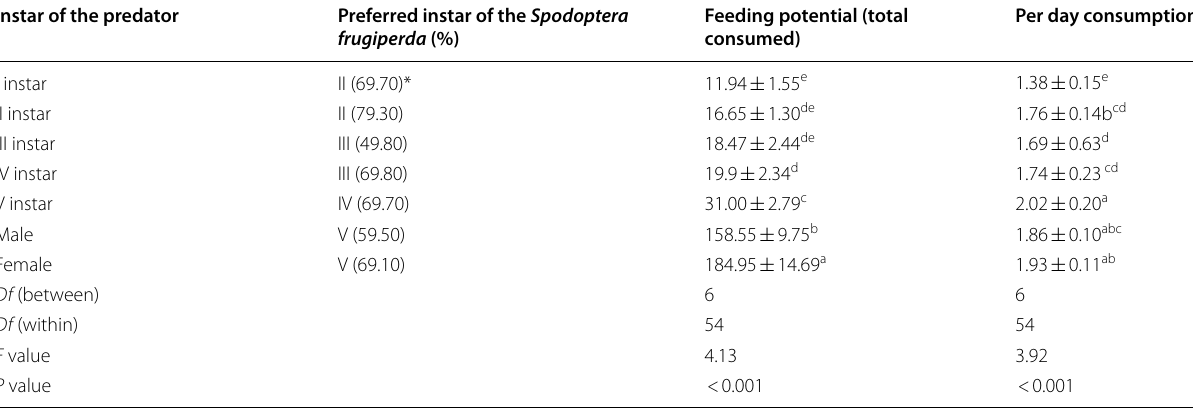
Means SD in the same column following same letter do not significantly differ by Tukey’s HSD ( P < ±